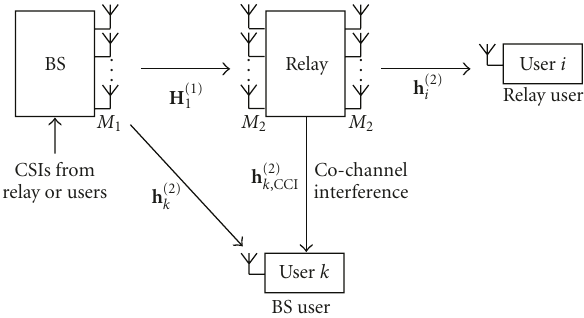
Figure 1: Modeling of a two-user two-hop MIMO relay system.